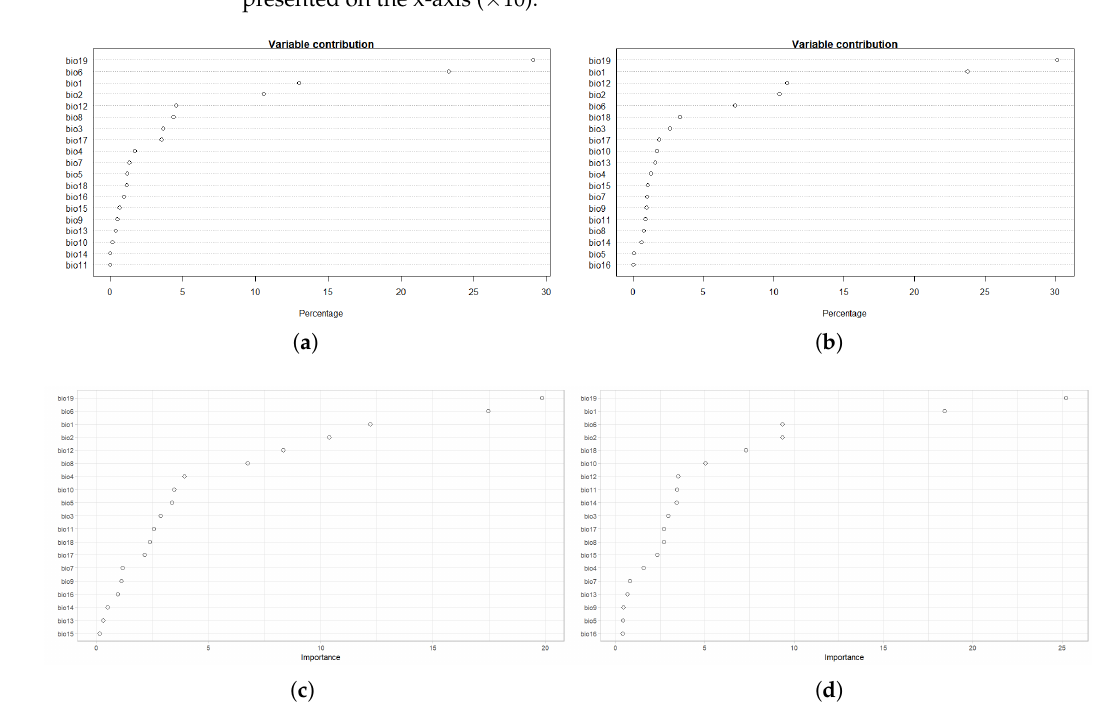
Figure A2. Variable importance indicating the contribution (%) of each predictor to the models. Full models ( a , c ) and reduced models ( b , d ) for BT and IBR,